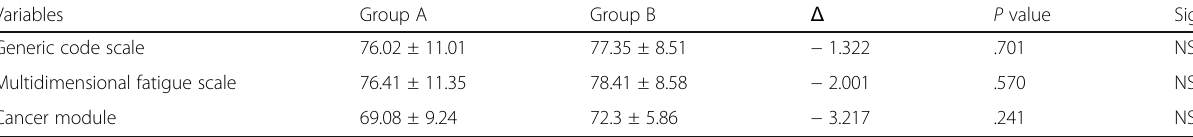
Table 9 Comparison of the mean values of quality of life after treatment among groups A and B